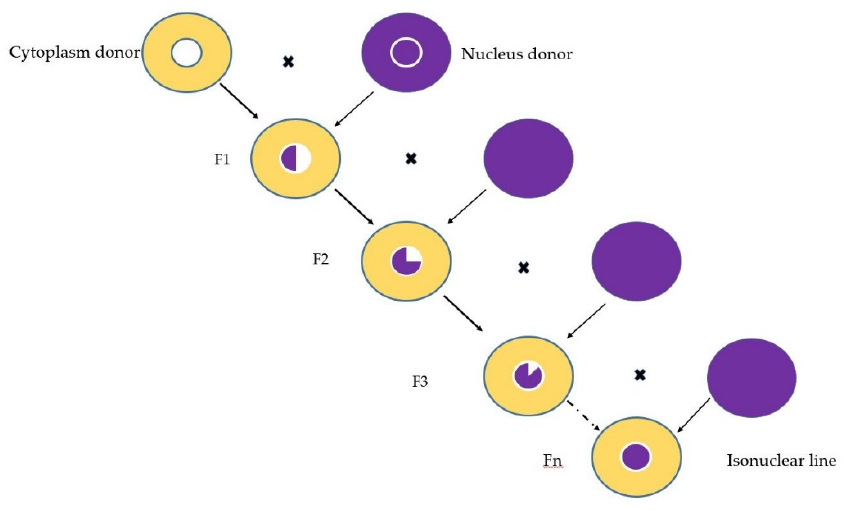
Figure 2. Nucleus transfer into a different cytoplasm through backcross in order to create isonuclear lines .